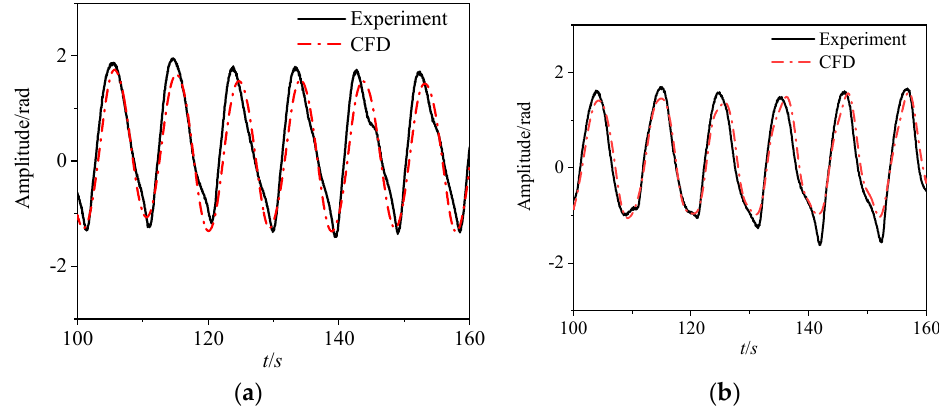
Figure 7. Pitch motion response of the floats in the middle with ( a ) H = 1.5 m and T = 9.5 s as well as